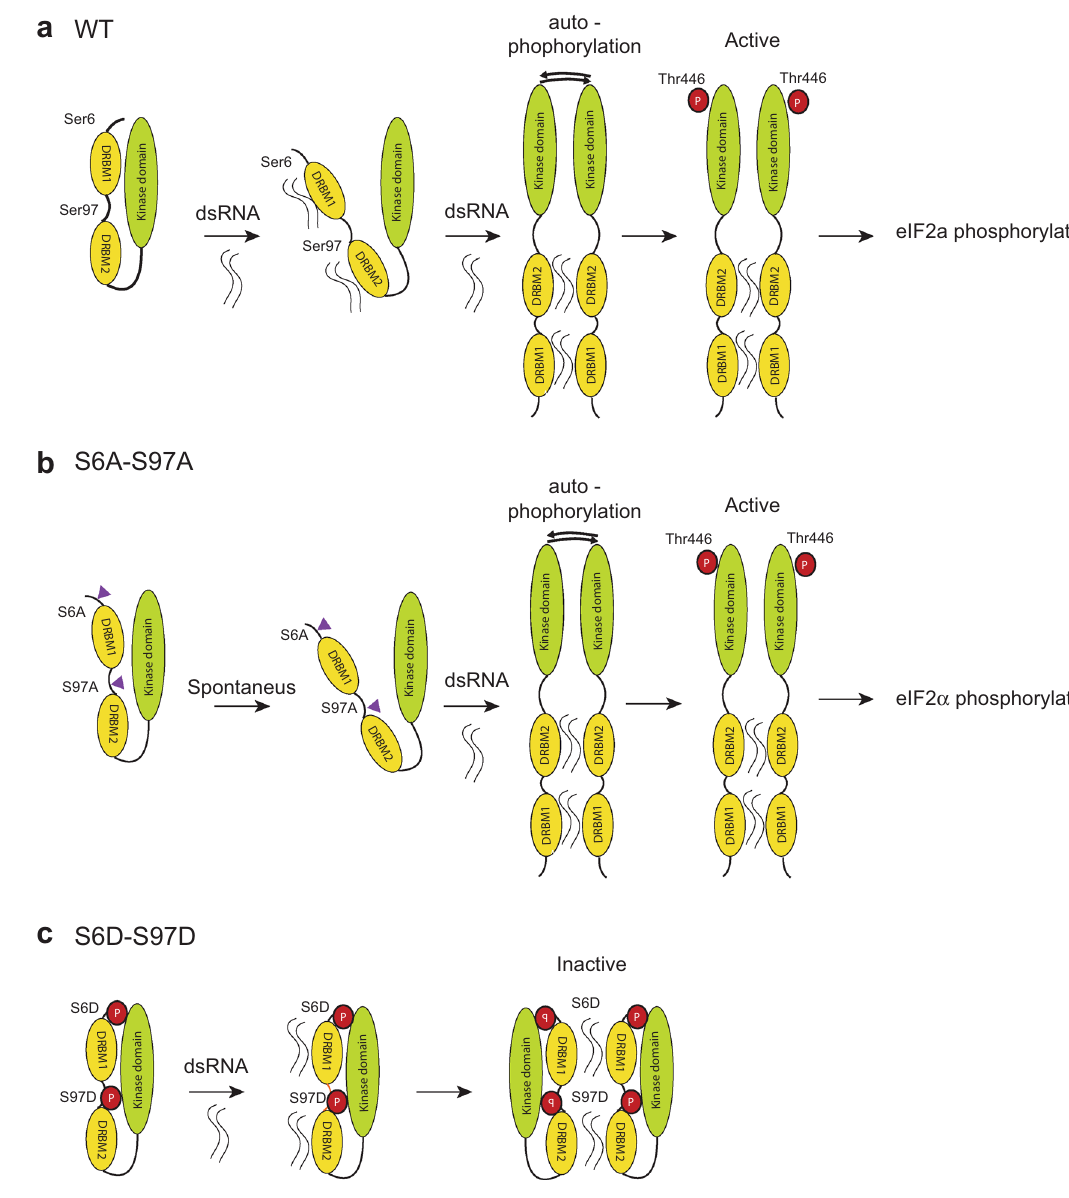
Figure 8. Model: Ser6 and Ser97 mutations impact the stability of the closed PKR conformation. ( a ) Wild type PKR: dsRNA binding by DRBM1 and/or DRBM2 destabilizes the interaction between the RNA binding domain and the kinase domain, leading to opening, dimerization, autophosphorylation and activation of the kinase activity. ( b ) The Ser-to-Ala mutations spontaneously destabilize the close conformation and facilitate opening of PKR upon dsRNA binding. ( c ) Ser6 and 97 phosphorylation or Ser-to-Asp phosphomimetic mutations prevent neither dsRNA binding nor dimerization but likely contribute to maintain PKR in a close, inactive